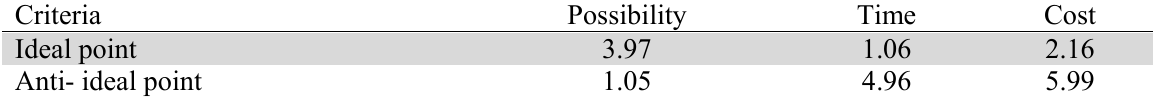
Minimum coverage for anti- ideal Indicators of crisis management Possibility Human Resource Management Appropriate management style Financial resources Communication Organizational flexibility Readiness of system against crisis Learning from the results Speed of responding and coping with crisis Ability of the system retrieval after the